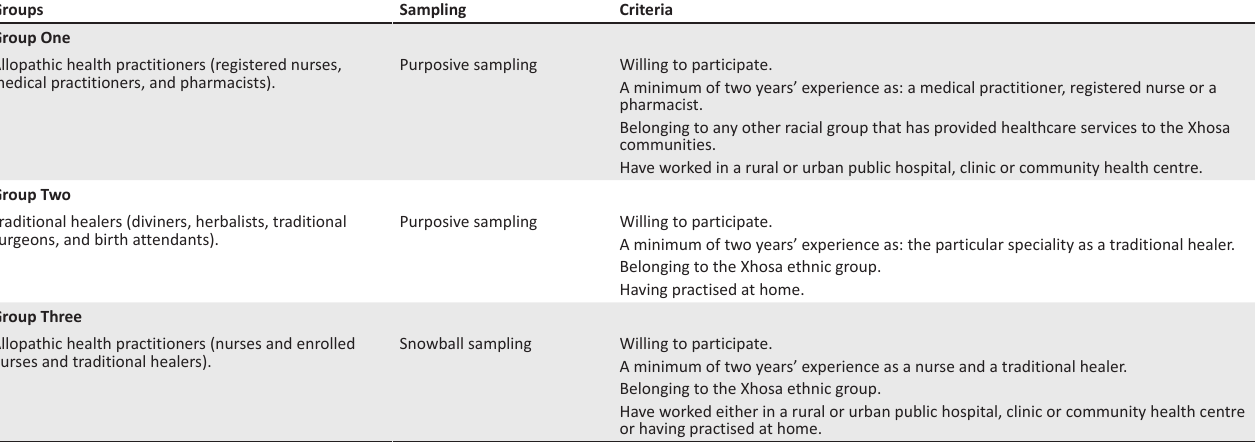
TABLE 1: Participant groups, sampling methods and inclusion criteria outlines the groups of participants, sampling and criteria.